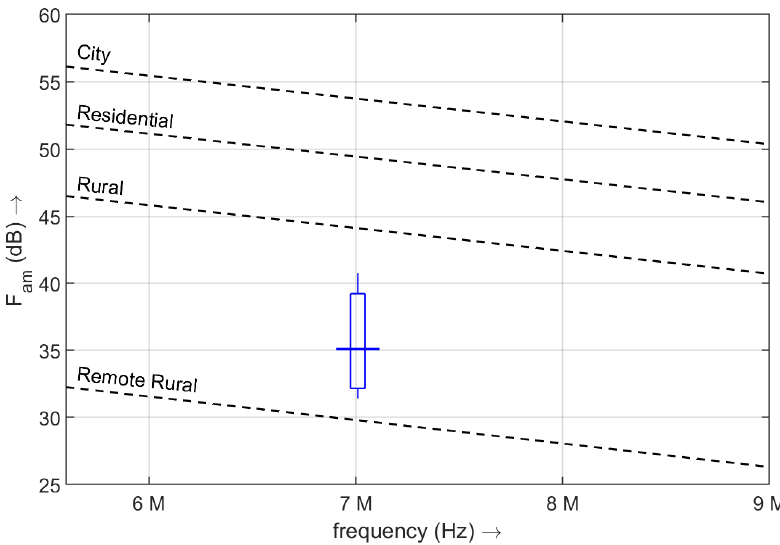
Figure 14. Graphical representation of the statistics of the ambient noise factor values, calculated from all measurements together. The median value is shown as a horizontal dash. The 10-th to 90-th percentile are shown as a box. The vertical lines show the extreme values. The predicted values from Recommendation ITU-R P.372-15 are shown as dashed lines.